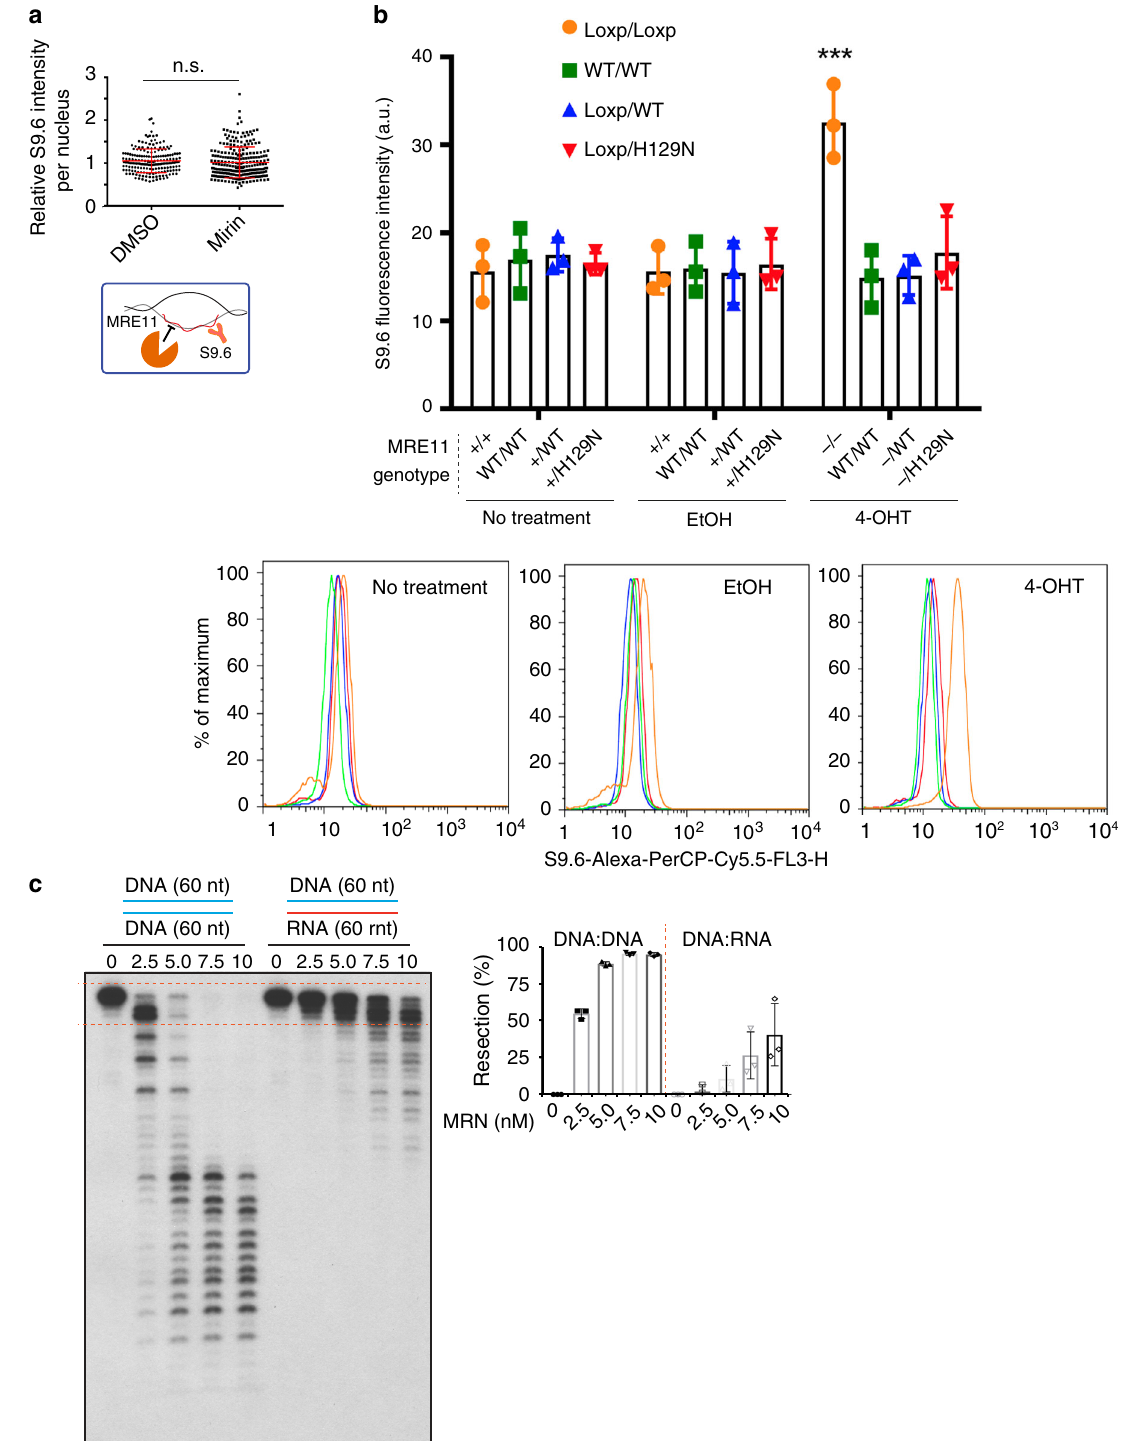
Fig. 5 A structural role for the MRN complex in mitigating R-loop associated DNA damage. a Nuclear S9.6 staining intensity after treatment with MRE11 inhibitor Mirin (50 μ M ) is shown. N = 3; t test; mean ± SD. A schematic showing the goal of testing MRE11 nuclease activity on R-loops is show. b Mean S9.6 fl uorescence intensity of TK6-derived lymphoblasts of the indicated genotype after treatment with EtOH (control) or 4-OHT, to induce gene knockout. Representative FACS histograms are shown below, curve colors correspond to bar graph. N = 3; *** P < 0.001 by ANOVA; mean ± SEM. c Head- to-head comparison of dsDNA and DNA:RNA hybrid resection by puri fi ed MRN complex on 60-mer duplexes. The concentration dependent degradation of the input molecules is plotted on the